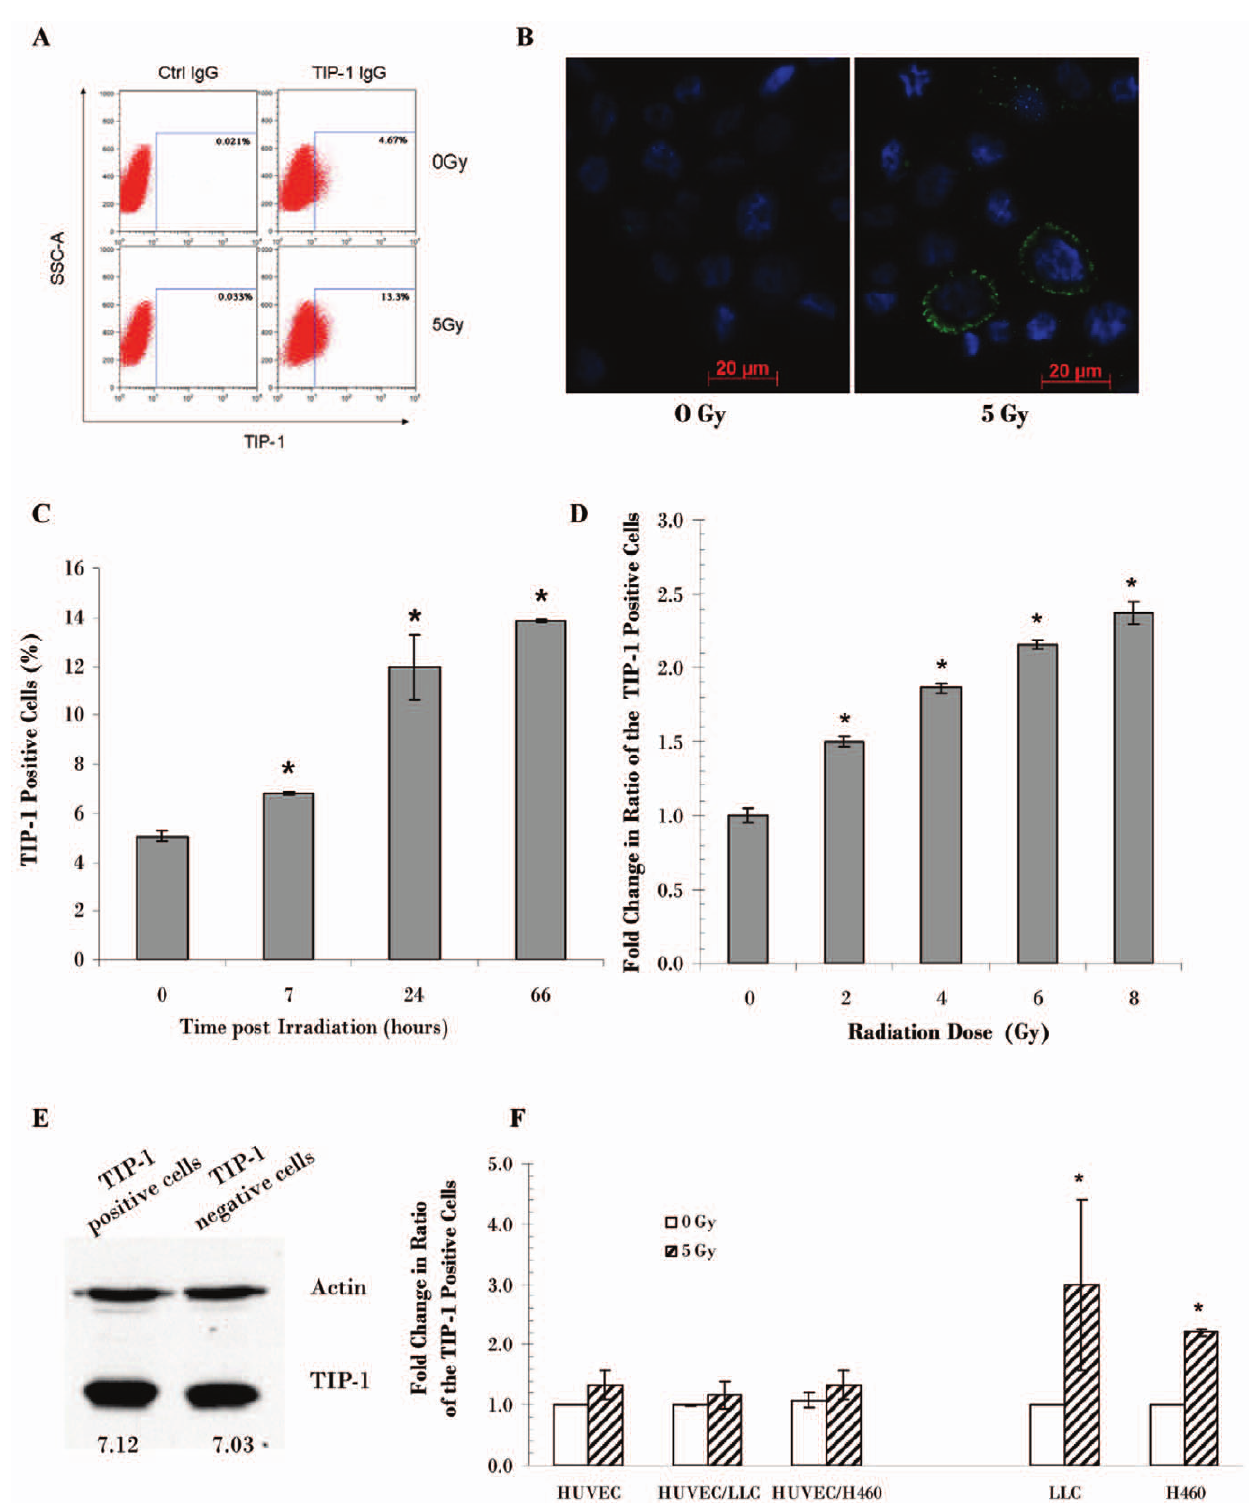
Figure 4. Radiation induced TIP-1 translocation onto the plasma membrane of the cancer cells. A : Flow cytometric profile of TIP-1 expression on the H460 cell surface. TIP-1 on the cell surface was detected with the TIP-1 antibody 24 hours after radiation treatment, a control IgG was included to demonstrate the antibody specificity. B : Fluorescent staining of the TIP-1 expression (green) on the cell surface of the irradiated H460 cells. DAPI was used for counterstaining. C : Time course study. The H460 cells were irradiated at 5 Gy and then fixed at variable time points after irradiation for flow cytometric analysis of the TIP-1 expression on the cell surface. Percentage of the TIP-1 positive cells was presented. D : The dose- dependence study. The H460 cells were irradiated with variable dose of X-ray, the cells were fixed 24 hours post the irradiation for profiling the TIP-1 expression on the cell surface with flow cytometry. Fold change of the TIP-1 positive cells was calculated by comparison to the untreated cells